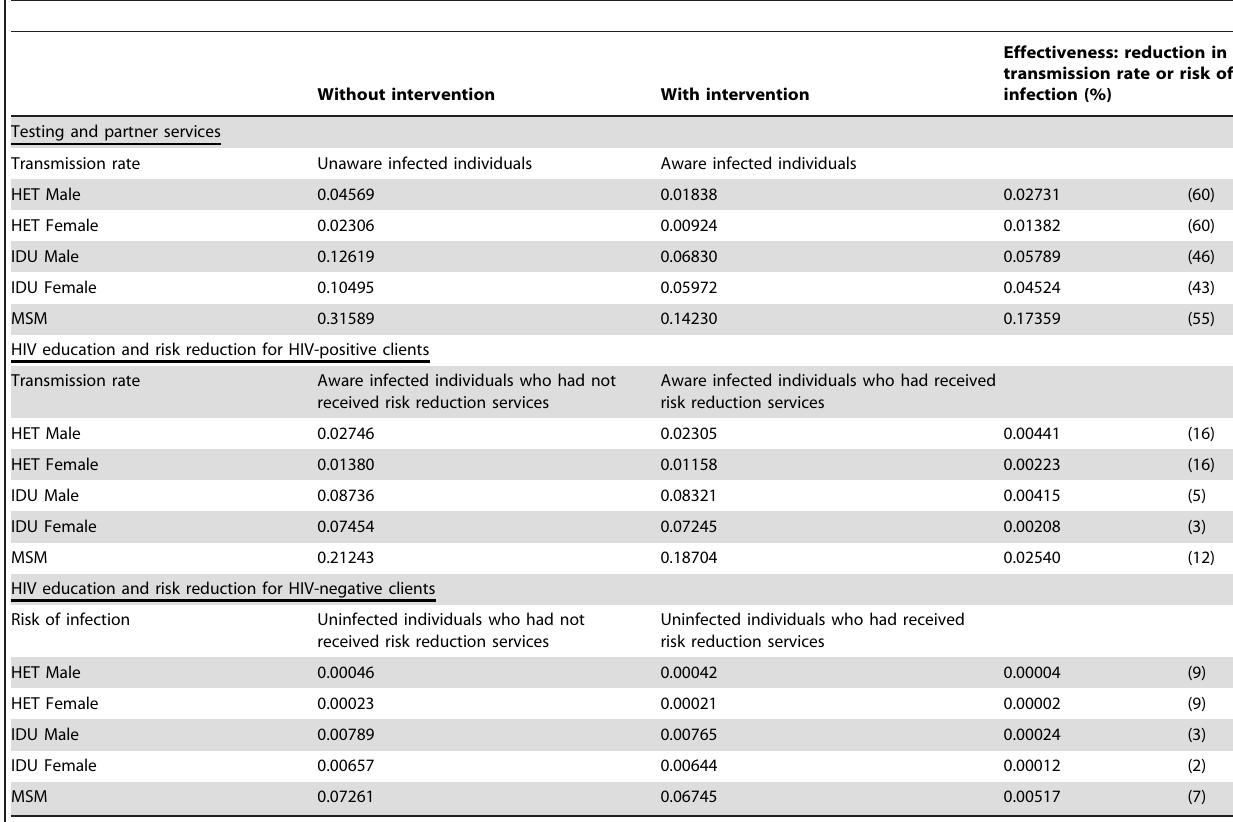
Table 3. Estimates of the HIV annual transmission rate for HIV-infected individuals, the risk of infection for uninfected individuals, and the effectiveness achieved by HIV prevention